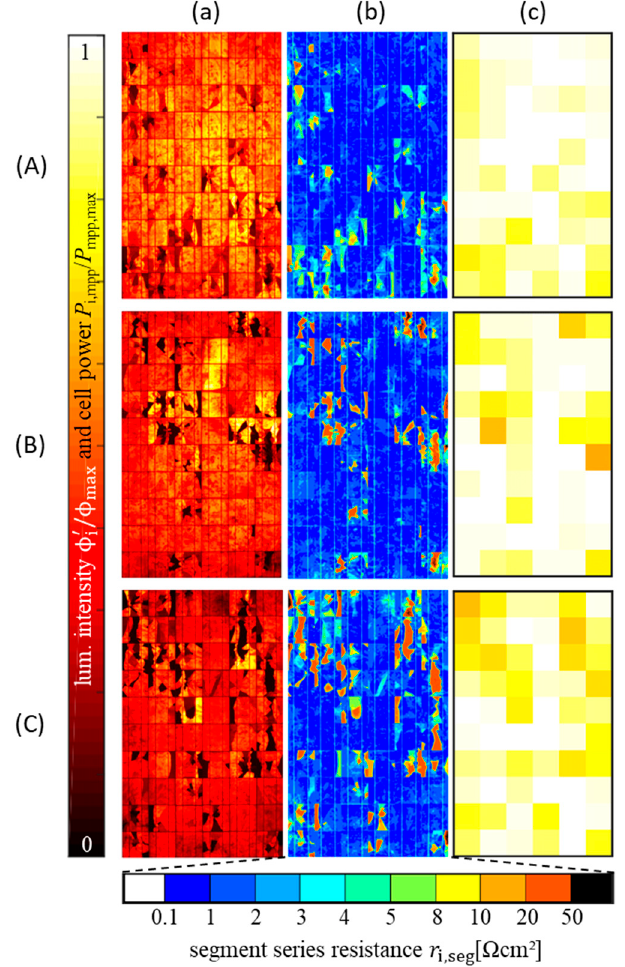
Figure 8. Normalized false color EL images ( a ), calculated series resistance maps colored by categorized mean series resistance of segments r i,seg ( b ) and simulated normalized power output of all cells of modules A, B and C ( c ). The simulated and normalized power output of cells identify the most severe defects in each module.